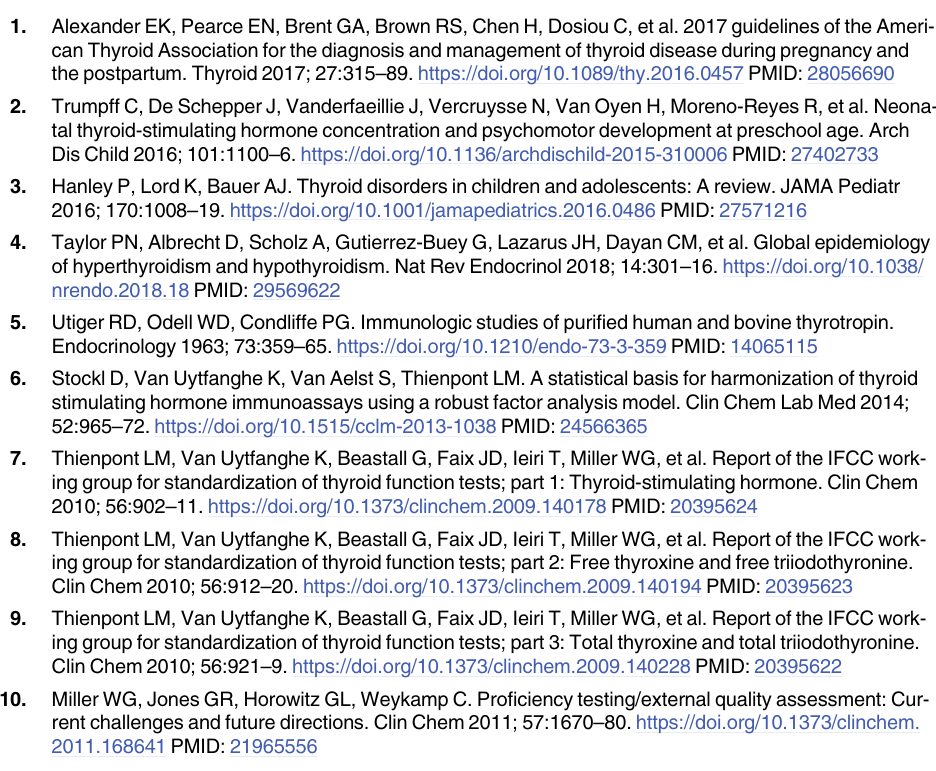
S4 Table. Systematic biases and commutability-related biases of NCCL EQA materials among 8 TSH immunoassays compared to ADVIA Centaur XP. S5 Table. Systematic biases and commutability-related biases of NCCL EQA materials among 8 TSH immunoassays compared to ADVIA CentaurXP after systematic biases were